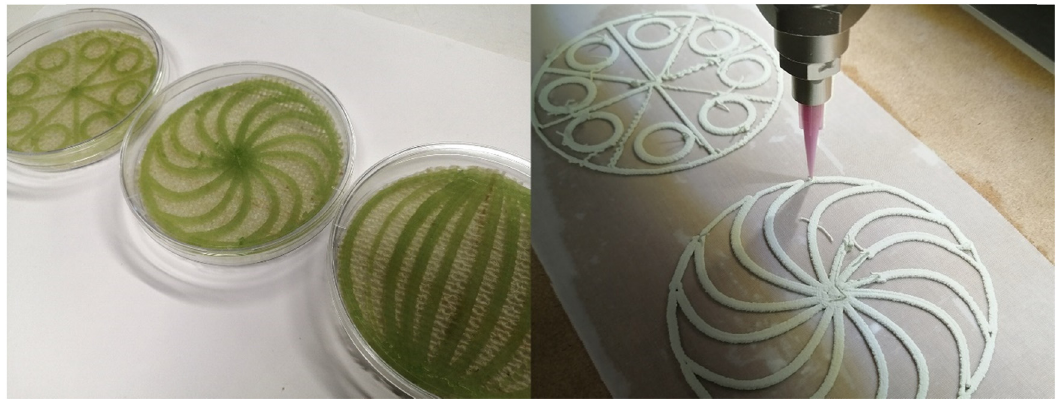
Figure 2: ( Left ) 3D printed algae cells in a kappa – carrageenan mixture on hessian during closed lid incubation, ( right ) 3D printing with 0.6 mm nozzle on wet cotton using living algae in Auro Clay Paint.